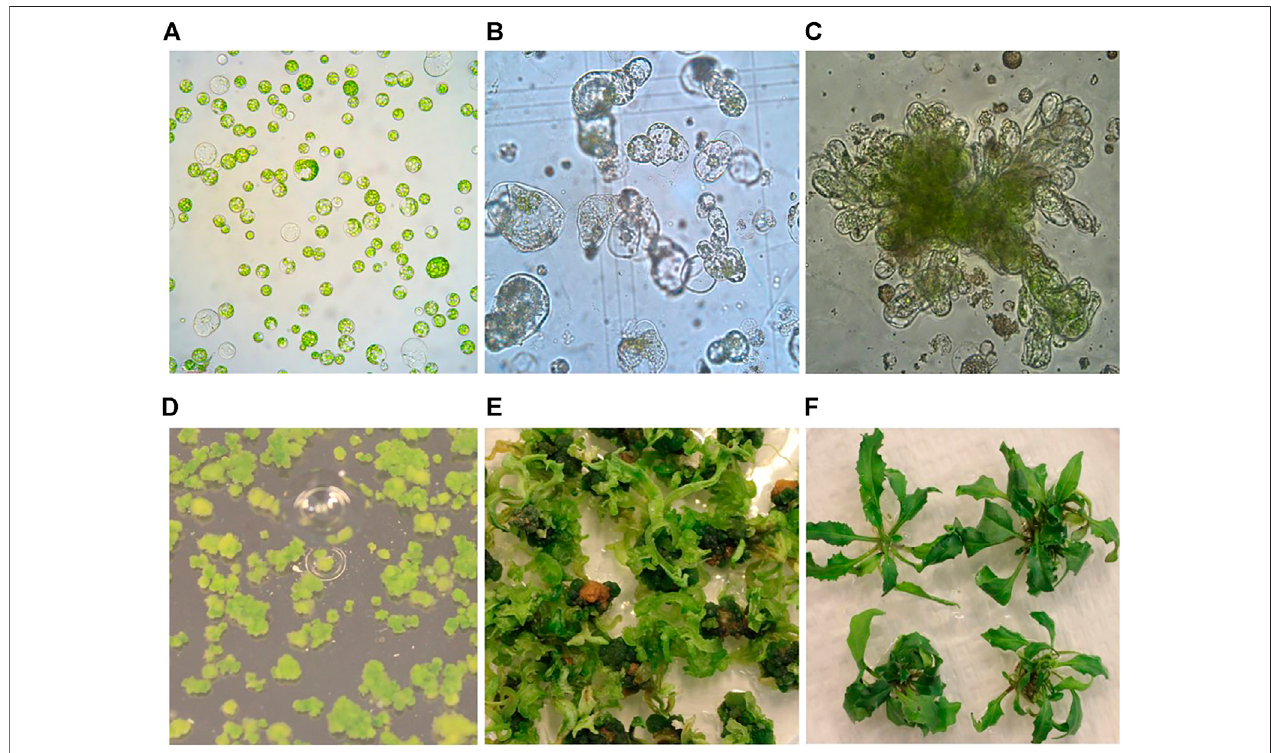
FIGURE 1 | Protoplast isolation, callus formation, and shoot regeneration of fi eld cress. (A) Freshly isolated protoplasts (1 day). (B) Protoplasts undergoing cell divisions and multiplication (0.5 month). (C) Protoplast callus formation (1 month). (D) Protoplast colonies (2 months). (E) Shoot regeneration from protoplast colonies (4 months). (F) Regenerated shoots grown on rooting medium (6